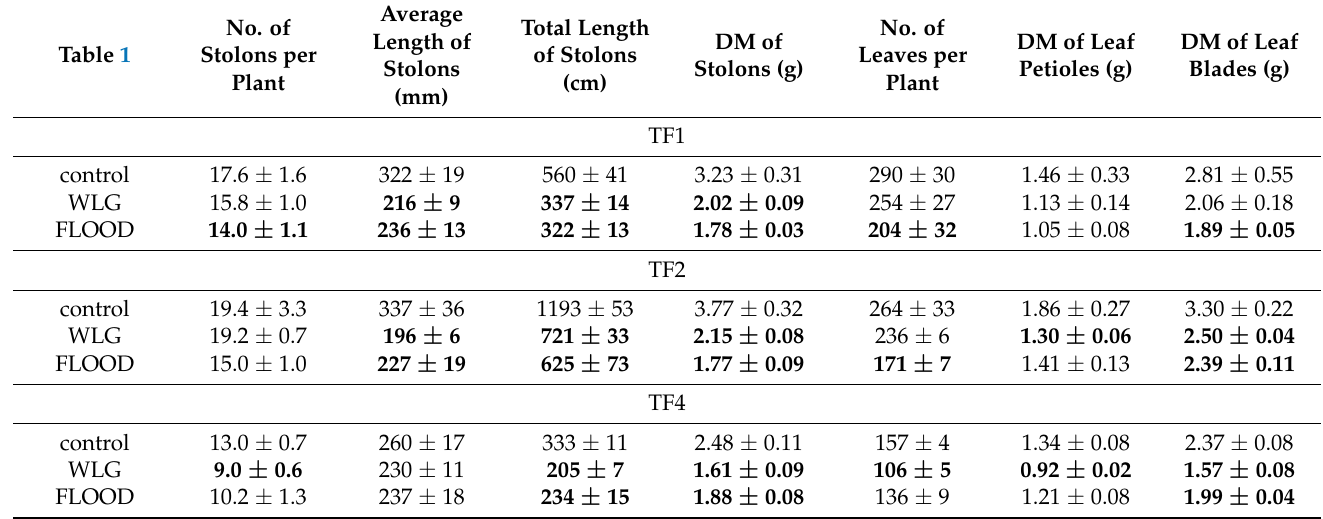
Table 1. Effect of increased soil moisture on morphological parameters and dry mass of shoot parts of different Trifolium fragiferum accessions. No. Table 1